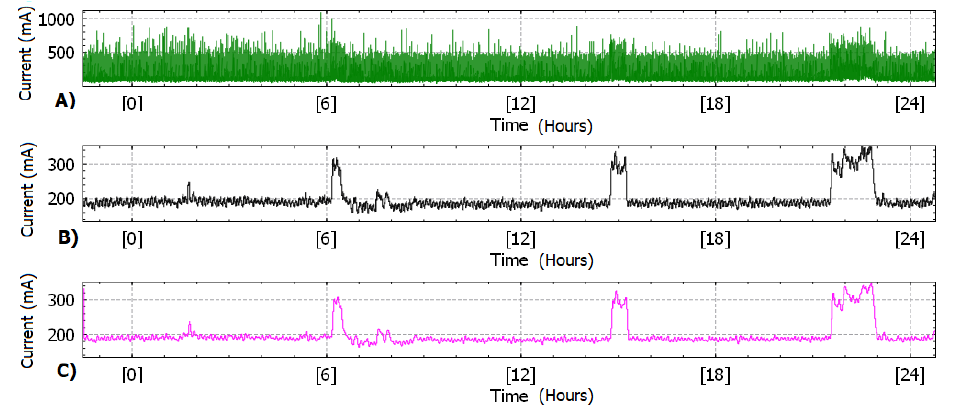
Figure 6. Measurement of operation under attack (Anomaly Profile) [7].